Question: Write a single sentence explaining what this figure depicts.
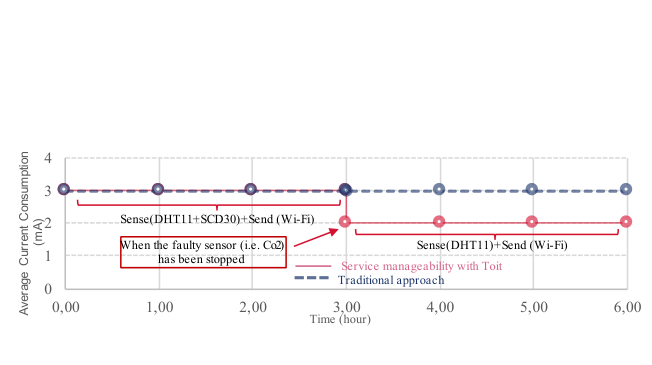
Answer: Comparison of the average current consumption of an IoT device considering service manageability and traditional method. Applying the pro- posed approach by leveraging Toit, the power consumption is reduced by, on average, 1 mA leading to a longer lifetime while keeping the system functional and reliable.